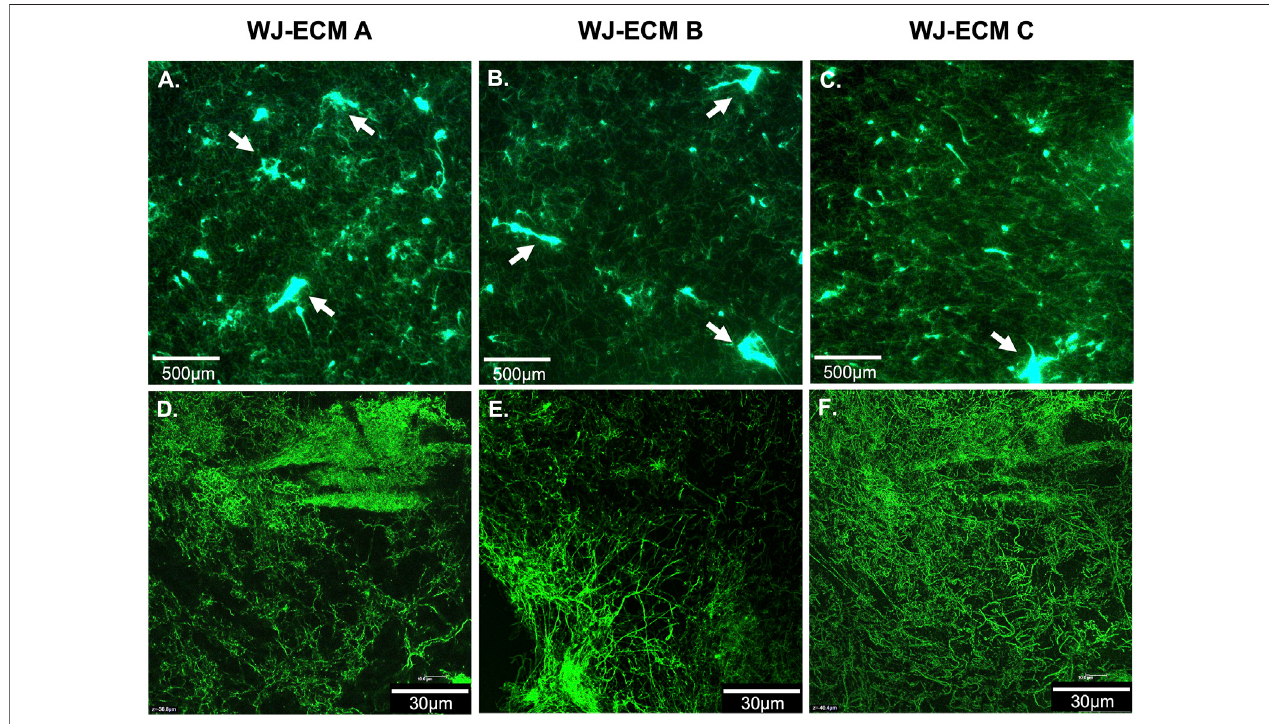
FIGURE3| MicroscopicobservationsofWJ-ECMaacoating. (A – C) Epi fl uorescenceimagesofWJ-ECMA,WJ-ECMB,andWJ-ECM C,respectively(aggregates are indicated with white arrows). (D – F) Confocal microscopy observations of WJ-ECM A, WJ-ECM B, and WJ-ECM C coating, respectively.